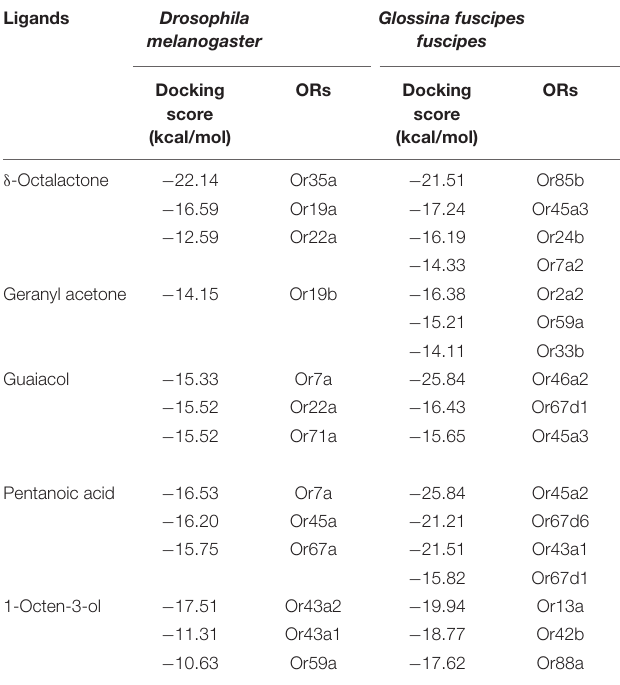
TABLE 1 | Docking scores of the potential receptors for WRB components and 1-octen-3-ol identified in G . f . fuscipes through ligand–receptor